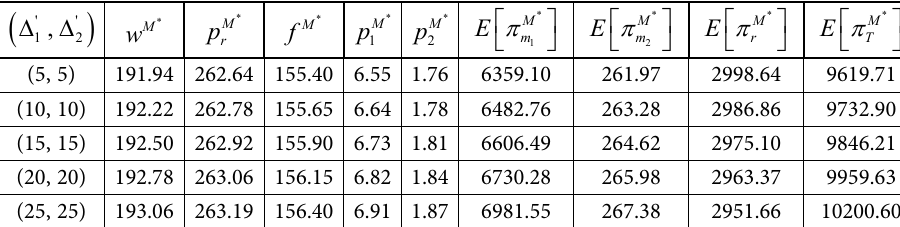
Table 7. Optimal values of the decision variables and the expected